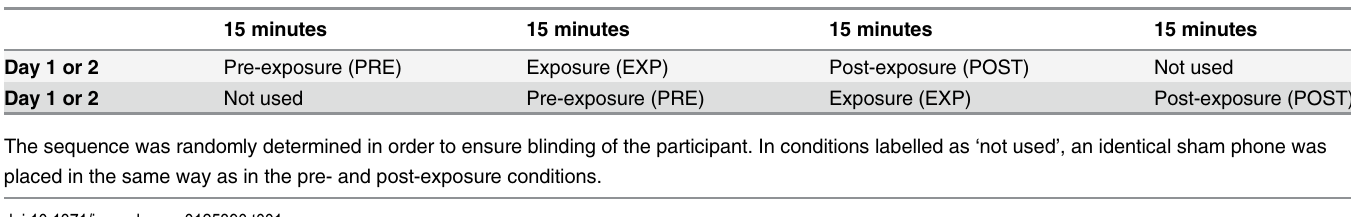
Table 1. Experimental